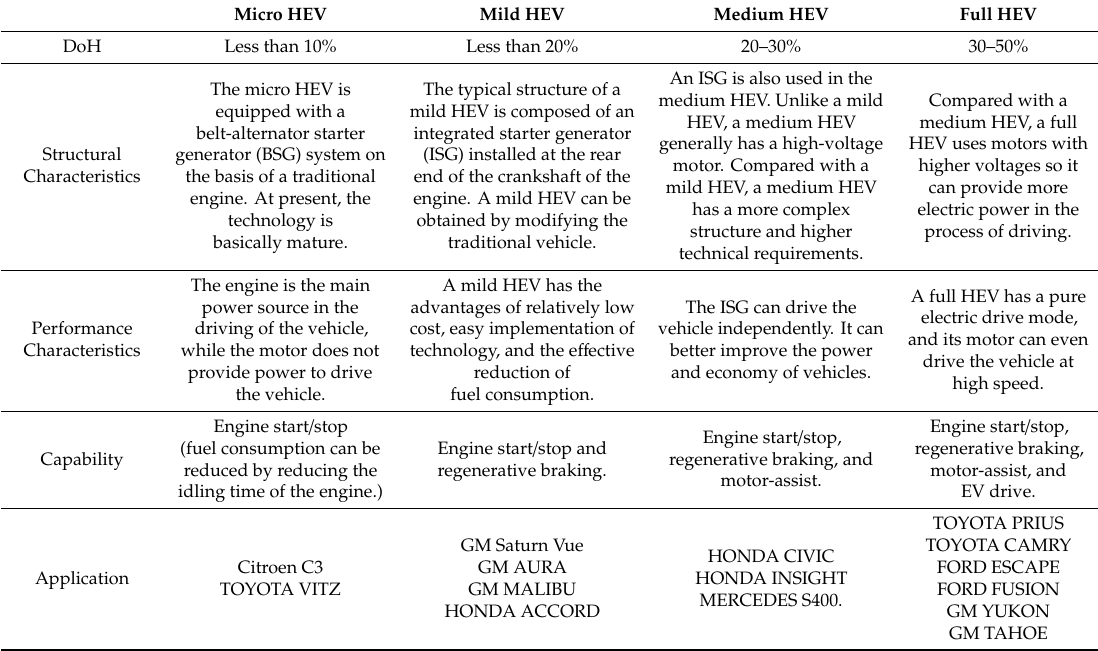
Table 1. Characteristics and applications of di ff erent